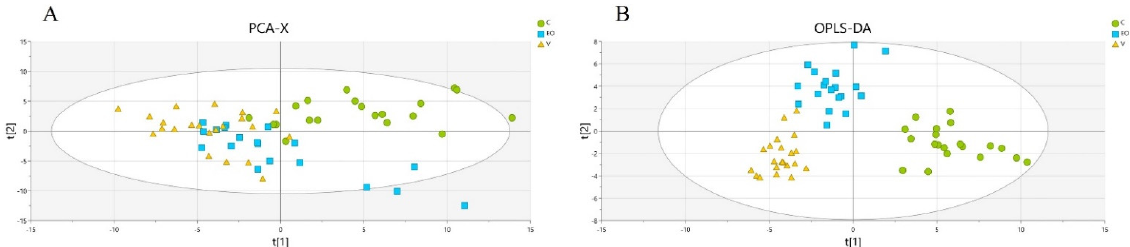
Figure 1. ( A ) Unsupervised PCA score plot of the three populations (EO: blue squares; C: green circles; and V: yellow triangles). ( B ) Supervised OPLS-DA score plot of the three populations. The model constructed with the 114 accurately measured molecules is able to discriminate the three groups. The axes t[1] and t[2] represent the first and second component, respectively, for the PCA, and predictive and orthogonal latent variables for the OPLS-DA.